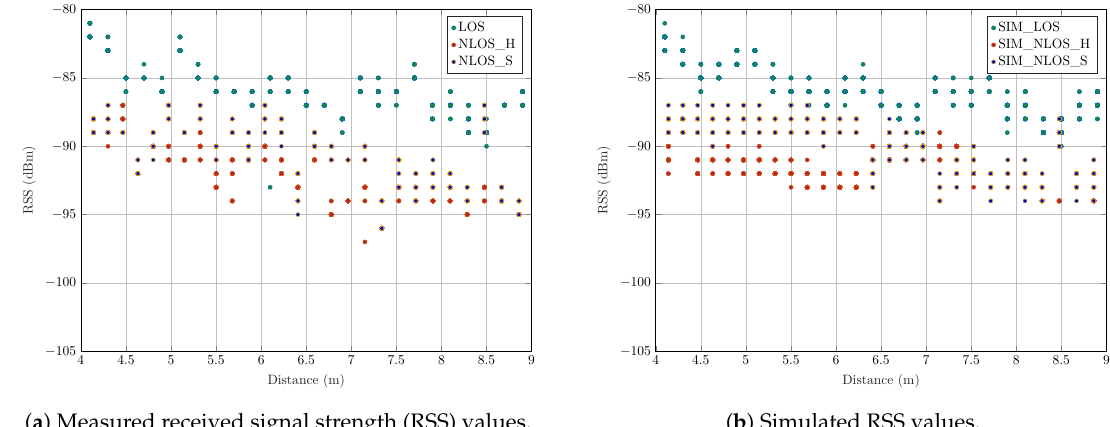
( b ) Simulated RSS values.